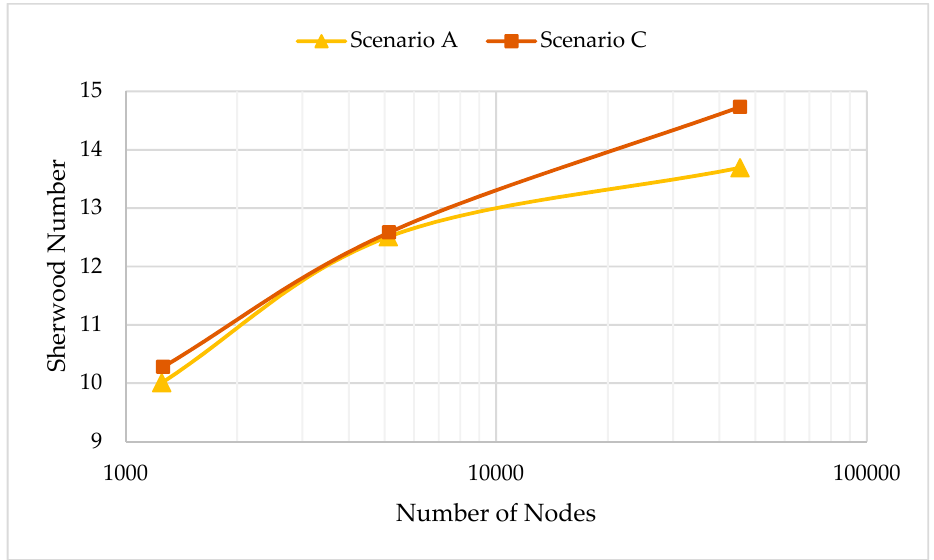
Figure 5. Variation of the average Sherwood number after three years (t = 3 years) versus the number of nodes used in the simulations (scenarios A and C).